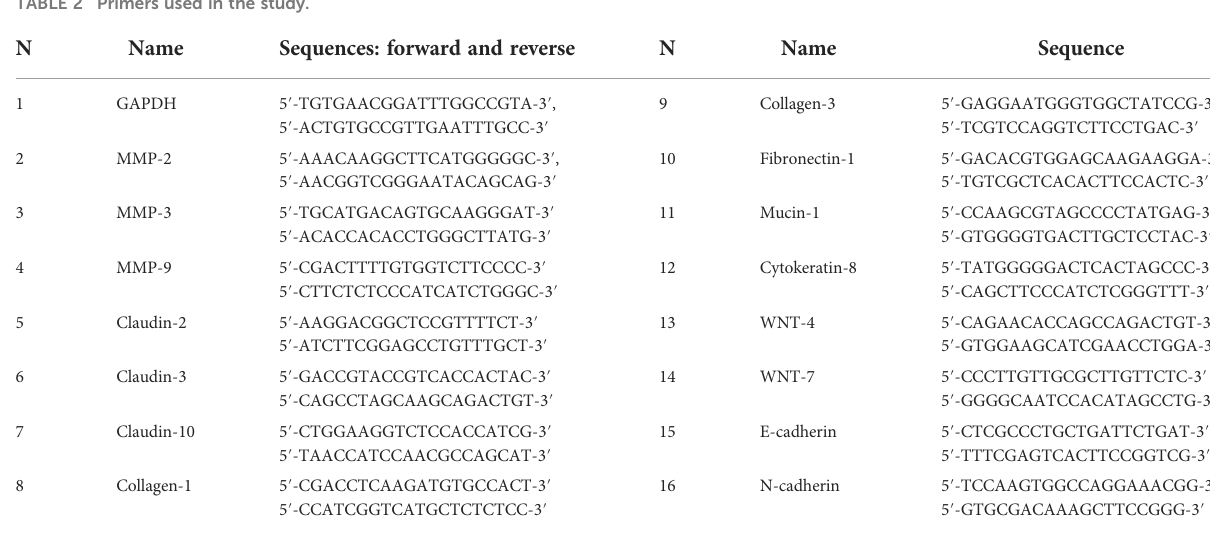
TABLE 2 Primers used in the